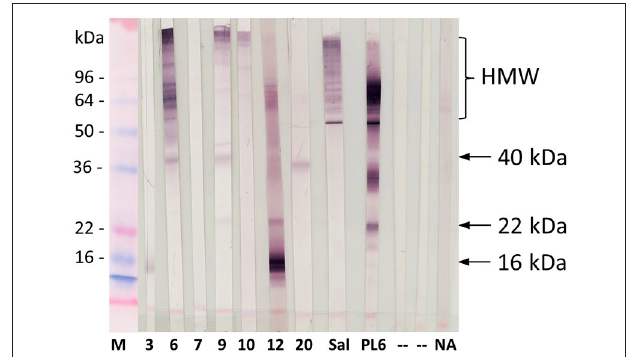
FIGURE 5 | IgE-reactivity pattern of cockroach-reactive patients from Venezuela ( n = 7, VR3, VR6, VR7, VR9, VR10, VR12, VR20) showing negative ImmunoCAP results for recombinant Periplaneta allergens, Germany (Sal), and pooled sera from cockroach-sensitized patients (PL6) with Periplaneta extract. M, marker; P, Ponceau S, staining; NA, non-atopic control; “-”, secondary antibody control. Arrows indicate the putative yet not identified